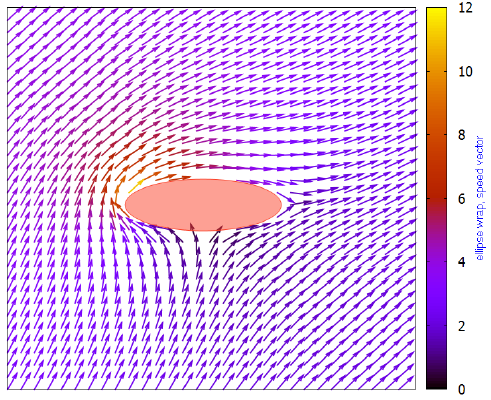
Fig. 8. Velocity field when an ideal fluid flows around an elliptical cylinder, .